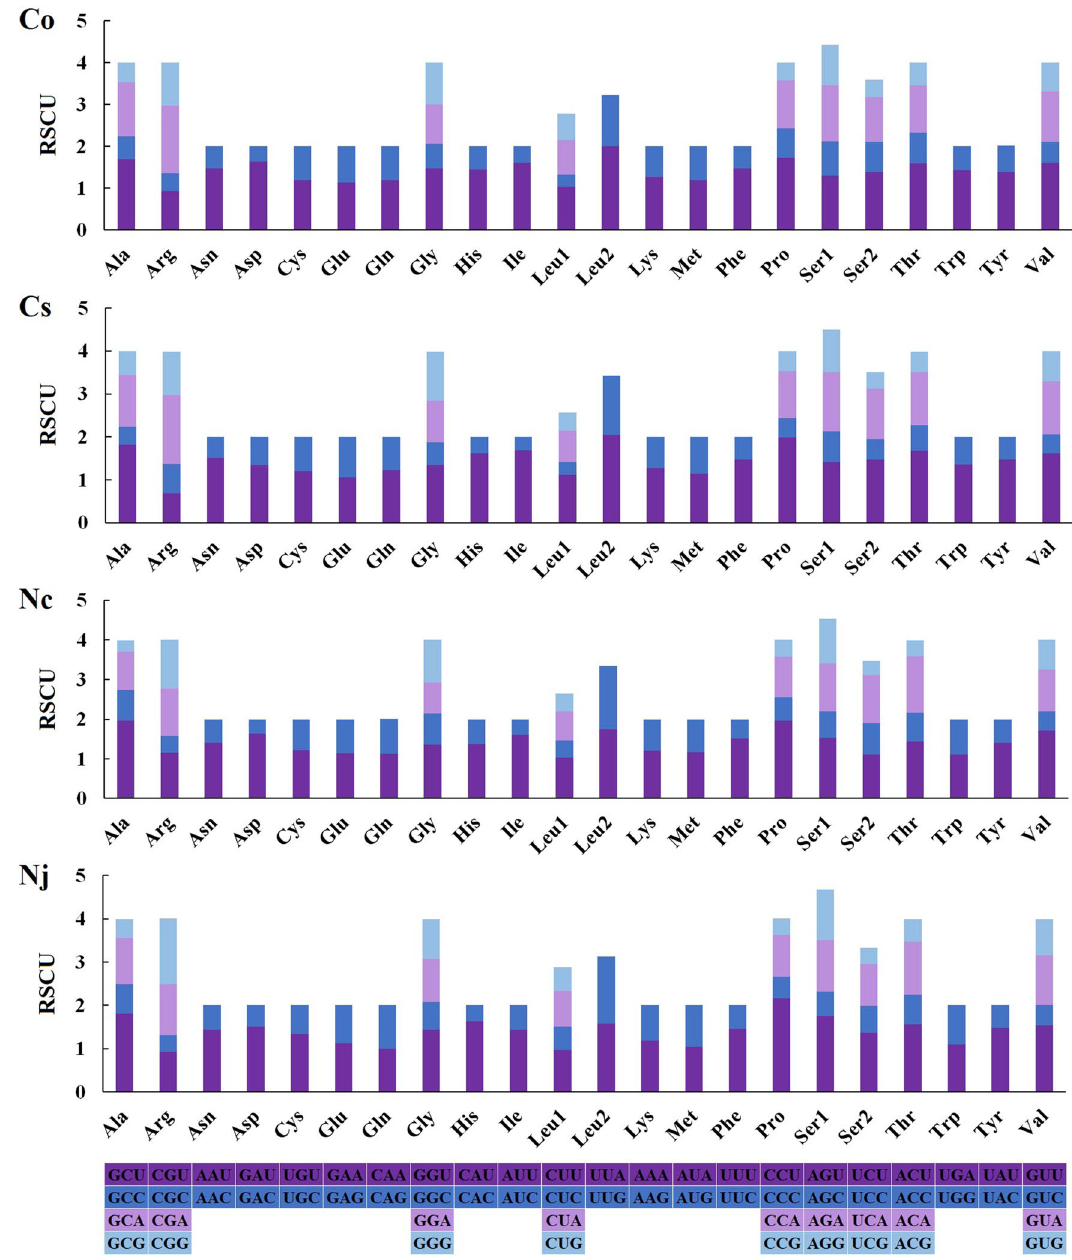
Figure 3. The relative synonymous codon usage (RSCU) in the mitochondrial genomes of four Neritidae species. Co indicates the RSCU of C. oualaniense , Cs indicates the RSCU of C. sowerbianum , Nc indicates the RSCU of N. chamaeleon , and Nj indicates the RSCU of N. japonica